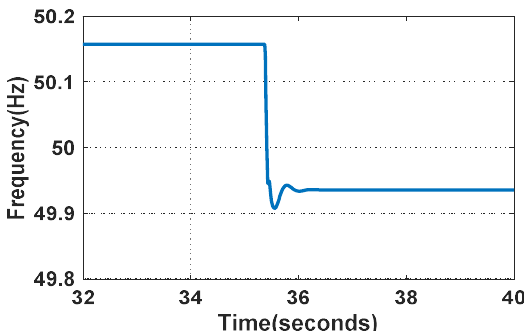
Figure 14. Transient frequency of the simulated test system.